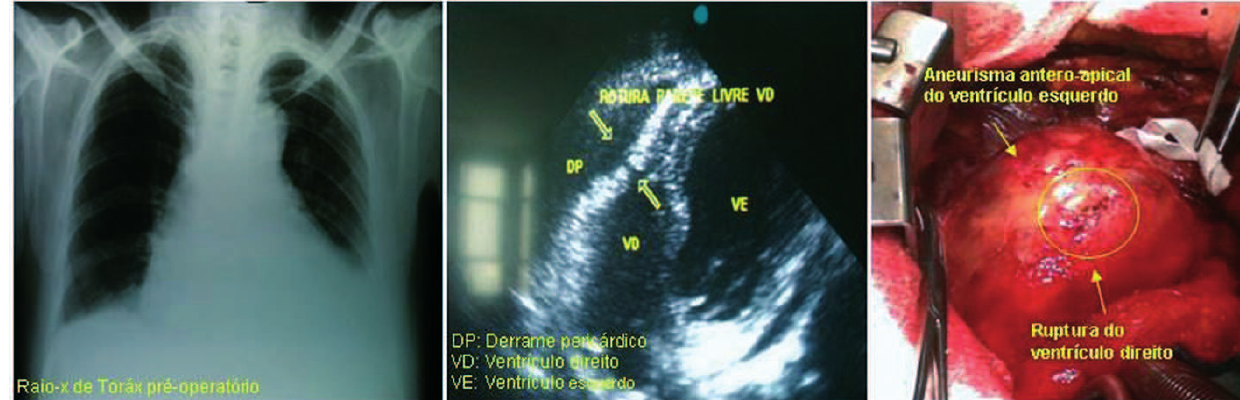
Fig. 1 - Radiografia de tórax, aspecto ecocardiográfico pré-operatório e imagem intraoperatória da